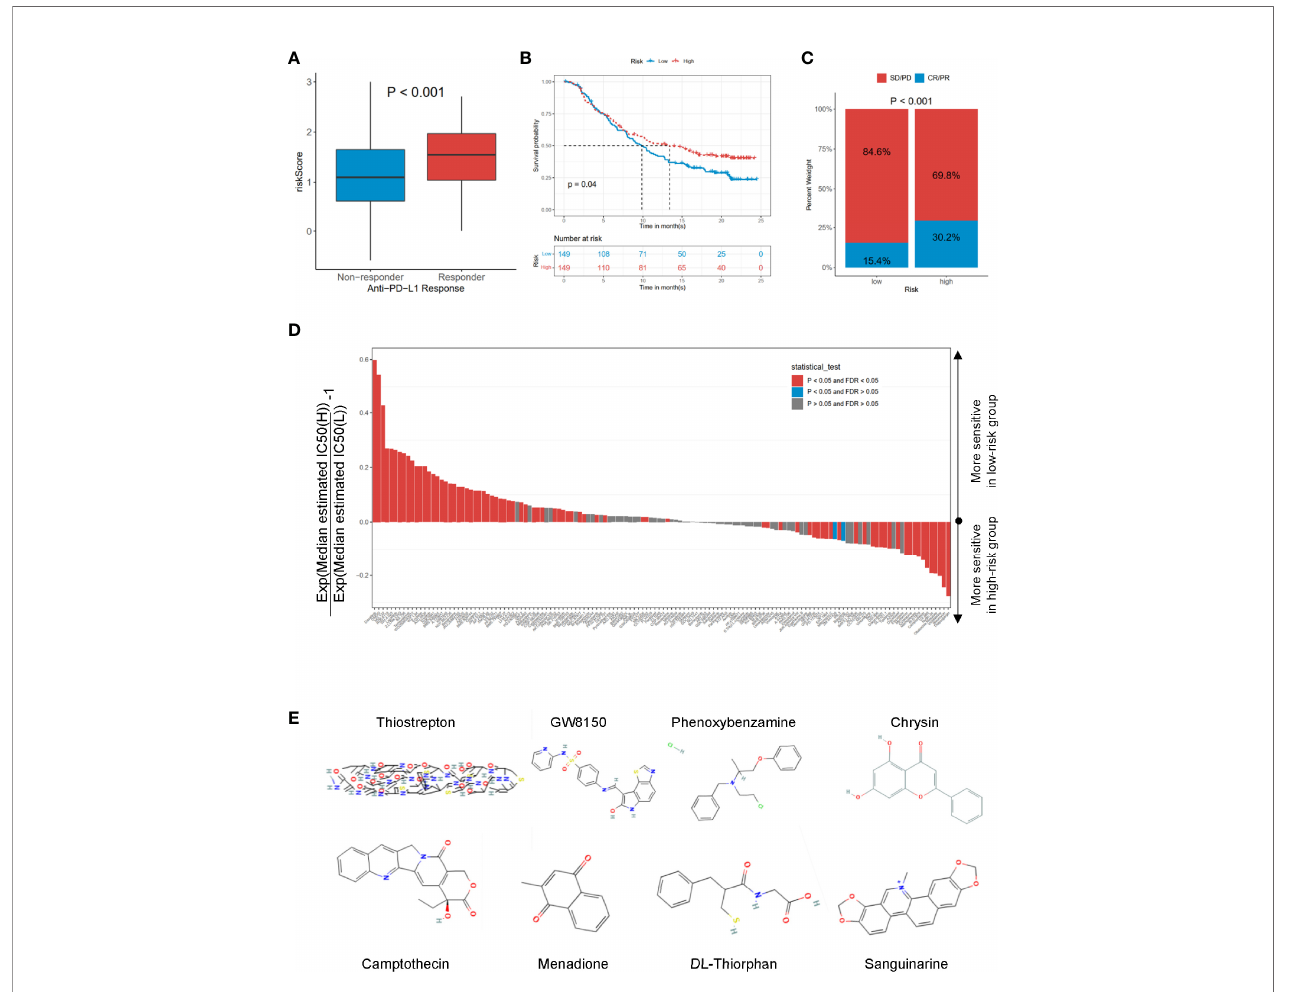
FIGURE 7 | The roles of risk scores in the prediction of immuno-/chemotherapeutic bene fi ts and candidate drugs. (A) Risk scores in high- and low-risk groups with different anti-PD-1 clinical response statuses. p < 0.001. (B) KM curves for high- and low-risk groups in the IMvigor210 cohort. Log-rank test, p = 0.032. (C) Rate of clinical response rate to anti-PDL1 immunotherapy in high- and low-risk groups in the IMvigor210 cohort. (D) Estimated IC50 for 138 compounds based on GDSC dataset. (E) 2D conformer of six signi fi cant candidate drugs. KM, Kaplan – Meier; GDSC, Genomics of Drug Sensitivity in Cancer.